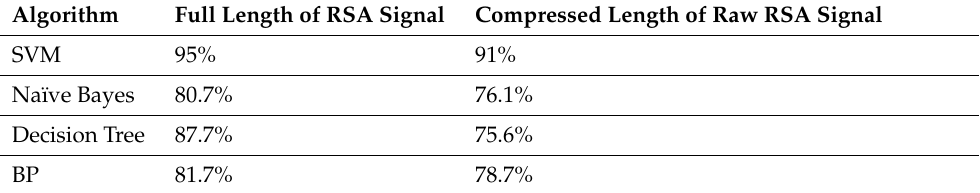
Table 3. Performance of different ML models with TD dataset.